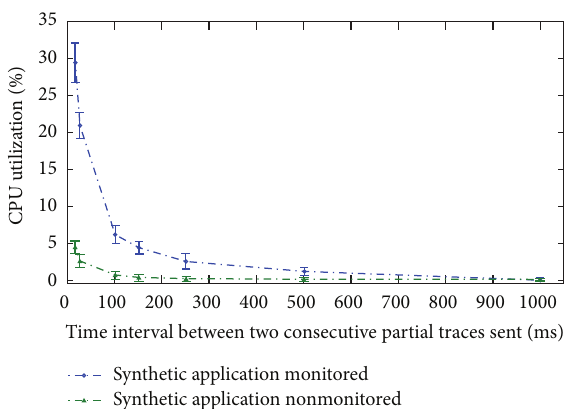
Figure 10: Difference of CPU utilization between an application monitored and